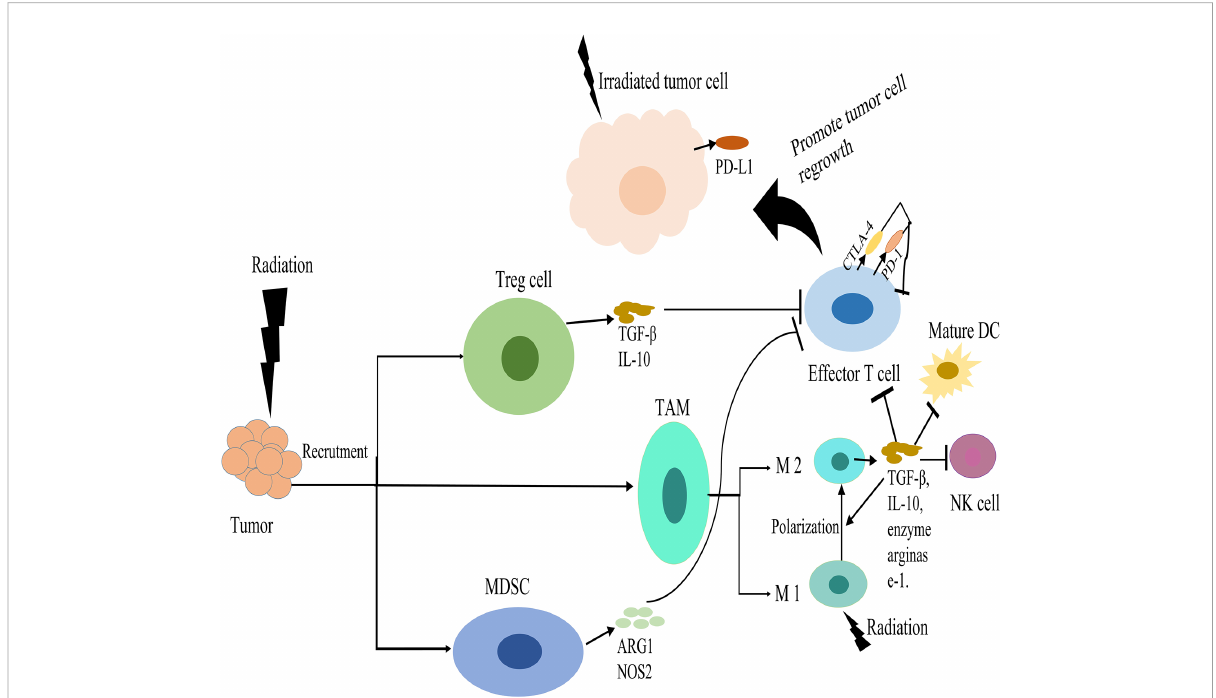
FIGURE 2 Immunosuppressive effects of radiotherapy. Radiation induces the recruitment of regulatory T cells (Tregs), myeloid derived suppressor cells (MDSCs) and tumor associated macrophages (TAMs) in the tumor microenvironment (TME). Tregs produce transforming growth factor beta (TGF b ) and IL-10, which suppress effector-T-cell activation. MDSCs can suppress the activation of T-cell responses via secretion of arginase-1 (ARG1) and nitric oxide synthase 2 (NOS2). Radiation can promote the polarization of macrophages from an in fl ammatory M1 phenotype into a tumor-supporting M2 phenotype. These M2 macrophages secrete IL-10 and TGF b and the enzyme arginase-1, which suppress T cell. TGF b can suppress the effector functions of T-cells and natural killer (NK) cells, inhibiting DC maturation, and promoting M2 macrophage polarity. Radiation stimulates upregulation of immune checkpoint inhibitory molecules, such as programmed cell death ligand 1 (PD-L1) on tumor cells and PD-1 or CTLA-4 on cytotoxic T cells, which down regulate T cell activation. These effects suppress the antitumor immunity and promote tumor cell